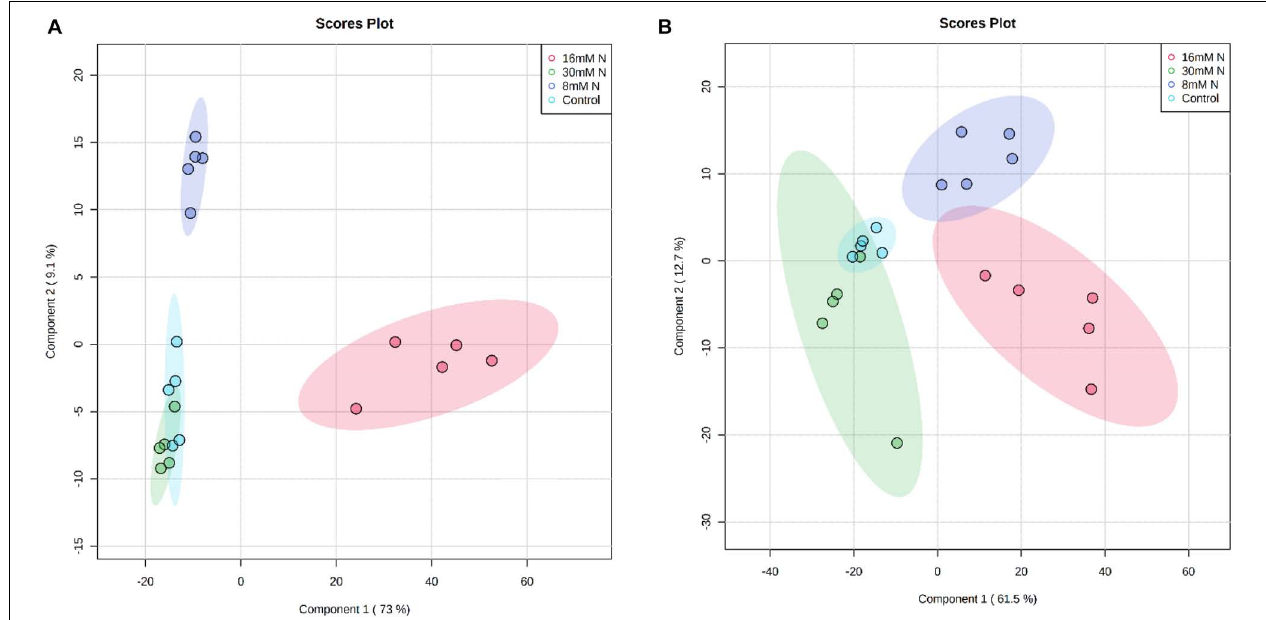
FIGURE 4 | Partial least squares discriminant analysis (PLS-DA) score plot of the first two principal components of the analysis of 789 secondary metabolites of strawberry cv. Albion (A) and cv. Camarosa (B) exposed to four levels of nitrogen (Green: 30 mM N, Red: 16 mM N, Blue: 8 mM N, and Turquoise: Control). The permutation cross-validation of the PLS-DA model had P = 0.0005 over 2,000 iterations. The ellipse represents a 95% confidence interval, and data points represent biological replicates ( n =